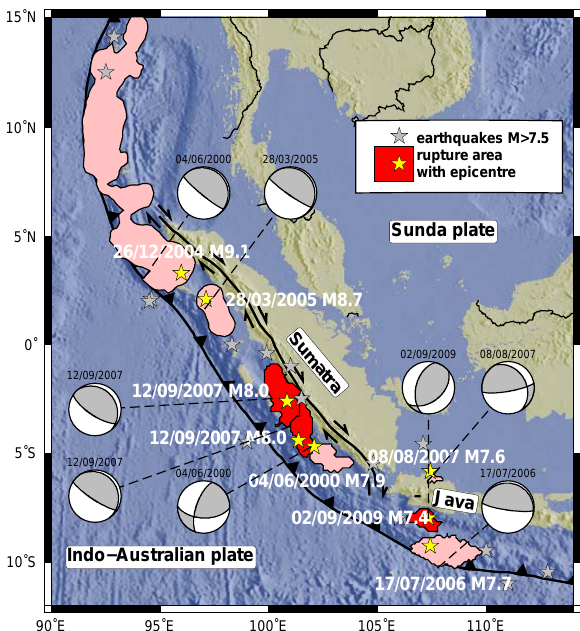
Fig. 7. Map of rupture areas for events in Table 1 along with cen- troid moment tensor solutions (Ekstr¨om and Nettles, 2009). Areas in red show the rupture areas of the events discussed in this paper. Areas in pink show the results for selected events since 2000. Blue stars show epicentres of other large earthquakes, M > 7 . 5, in this area since